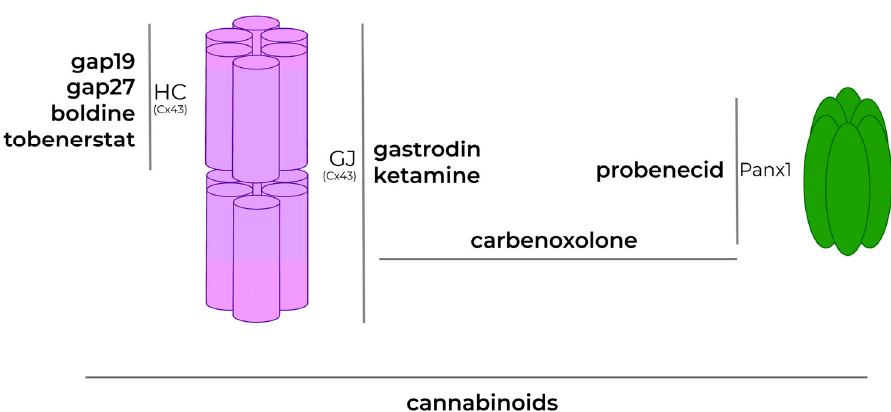
Figure 6. Cxs as potential pharmacological targets. Several compounds with a modulating effect to different targets were proposed: gap19, gap27, boldine, and tobenerstar for HCs; gastrodin and ket ‐ amine for GJs; probenecid for Panx1 channels. Carbenoxolone acts on both Panx1 channels and GJs, while CBs acts on Cx38, Cx26, and